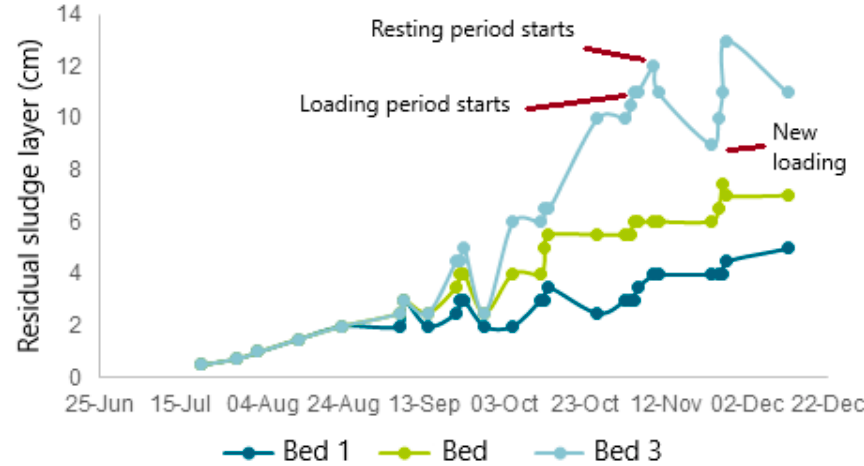
Figure 11. Residual sludge layer thickness (cm) in Beds 1–3 at the pilot STRB at the Whitacre WW during July–December 2015 [53].